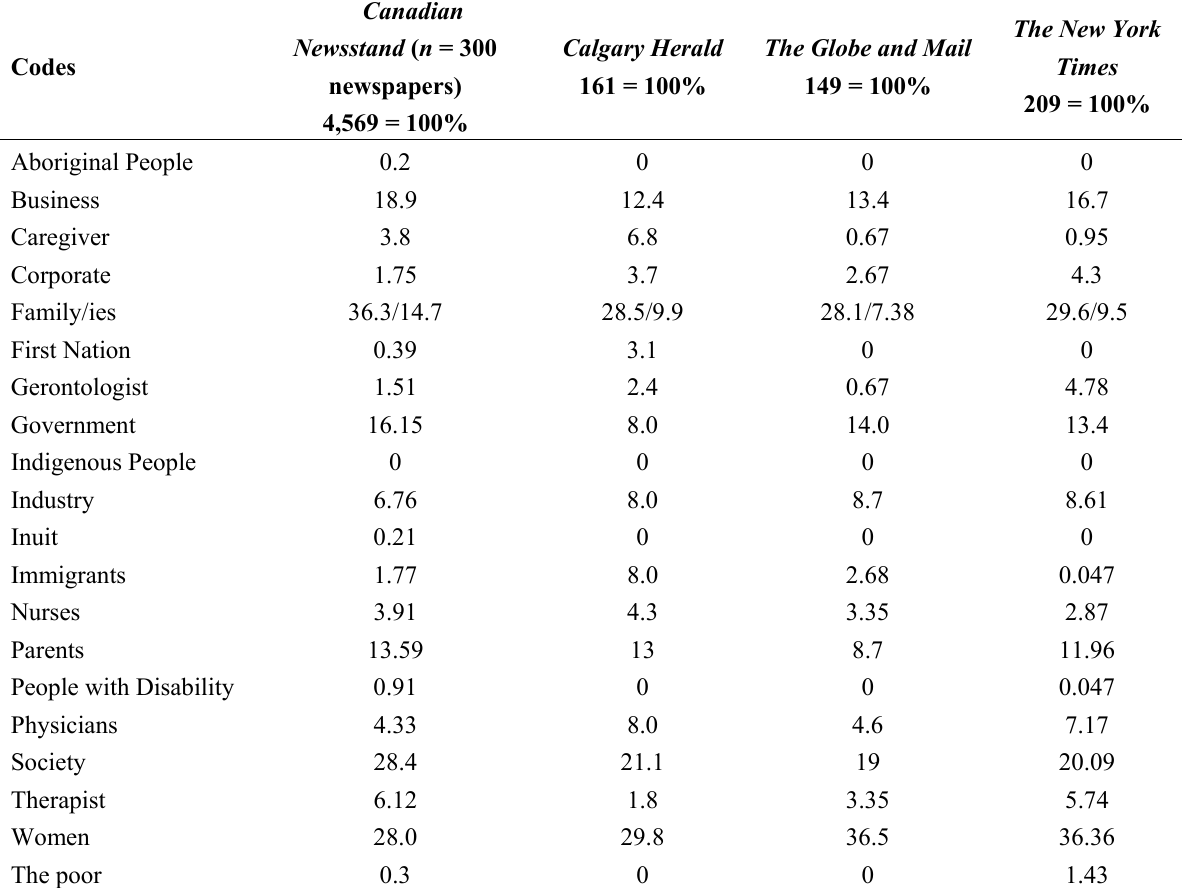
Table 2. Social groups mentioned in newspaper articles covering “active aging” or “natural aging” or “aging well” or “successful aging” or “healthy